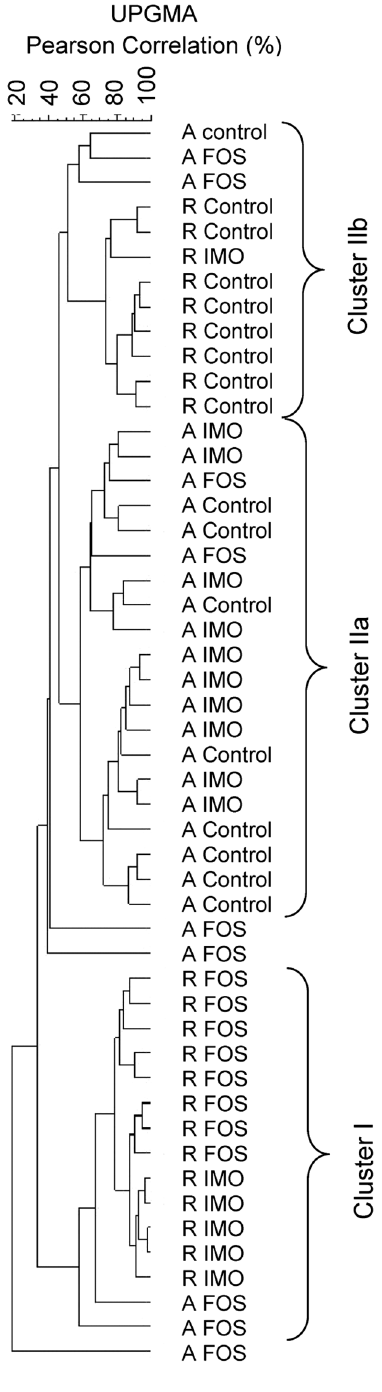
Figure 3. PCR-DGGE analysis of cecal microbiota of HLA-B27 transgenic rats. Samples are labeled with animal number, diet, and oligosaccharide preparation used. Animals on the AIN-76A diet are indicated with A; animals on the rat chow diet are indicated with R. Diets were supplemented with fructo-oligosaccharides (FOS) or with isomalto-oligosaccharides (IMO), or not supplemented with oligosac- charides (control animals). Cecal contents were collected for DNA extraction at the end point of the fibre treatment (16 weeks of age). UPGMA arithmetic algorithm based on Pearson correlation coefficient was used to conduct the